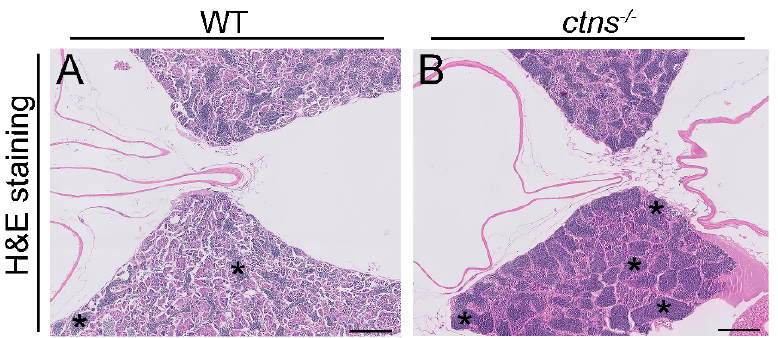
Figure 7. Spermatogenic cysts enriched in spermatozoa in ctns − / − zebrafish. ( A , B ) Representative H&E stained pictures of testis of wild-type ( A ) and ctns − / − ( B ) 18-month-old zebrafish. Dark blue and rounded staining represent the spermatozoa accumulated in the spermatogenic cysts (indicated with the asterisks). The scale bars represent 200 µm.